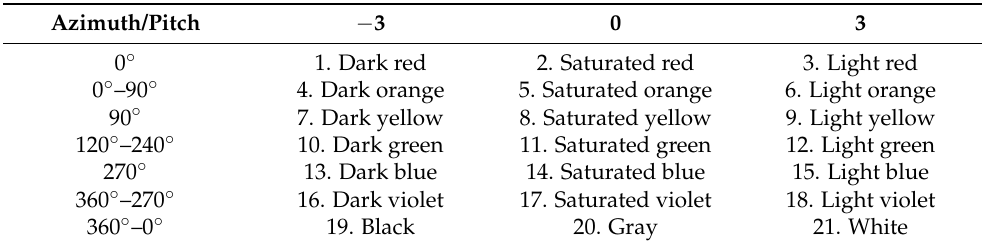
Figure 3. ( a ) Sound representations of 6-color wheel codes; ( b ) sound representations of 8-color wheel codes. Eight colors have three levels of brightness, expressed by changing the pitch of the sound. A normal audio sound represents saturated colors, an audio sound that raises three semitones represents a lighter color, and an audio sound that decreases three semi- tones represents a darker color. In this way, this paper proposes a color-coding system that can represent 24 chromatic colors and three achromatic colors. The strategy complies with the definition of light and dark colors in the Munsell color system, as shown in Figure